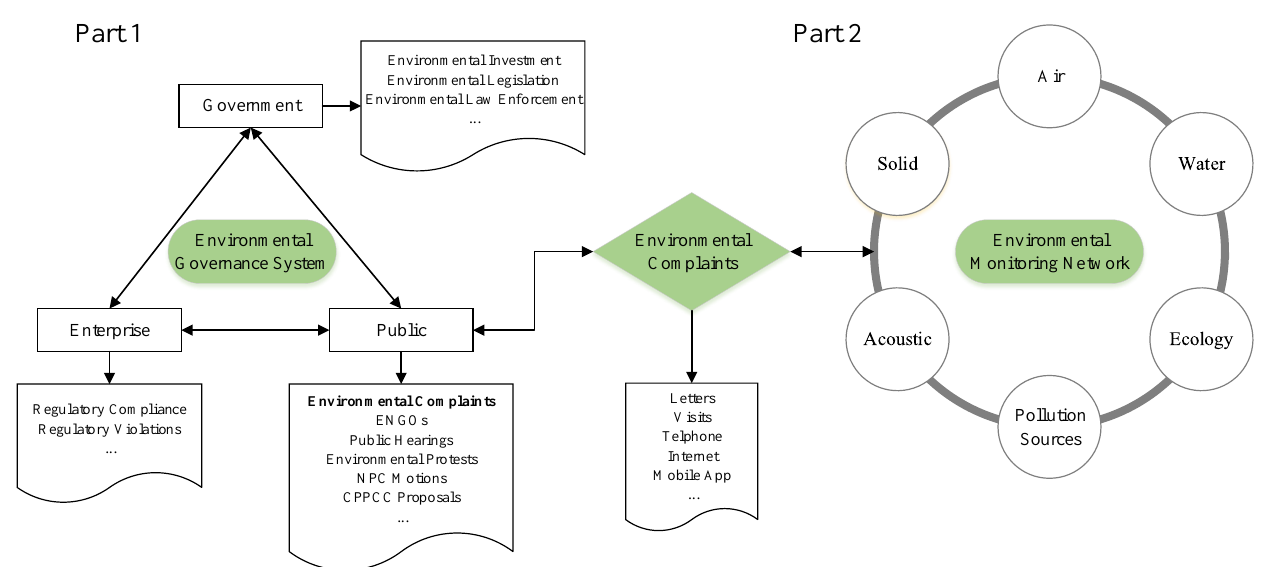
Figure 4. An analysis framework of the role of citizen environmental complaints in China’s environmental governance system and environmental monitoring network.